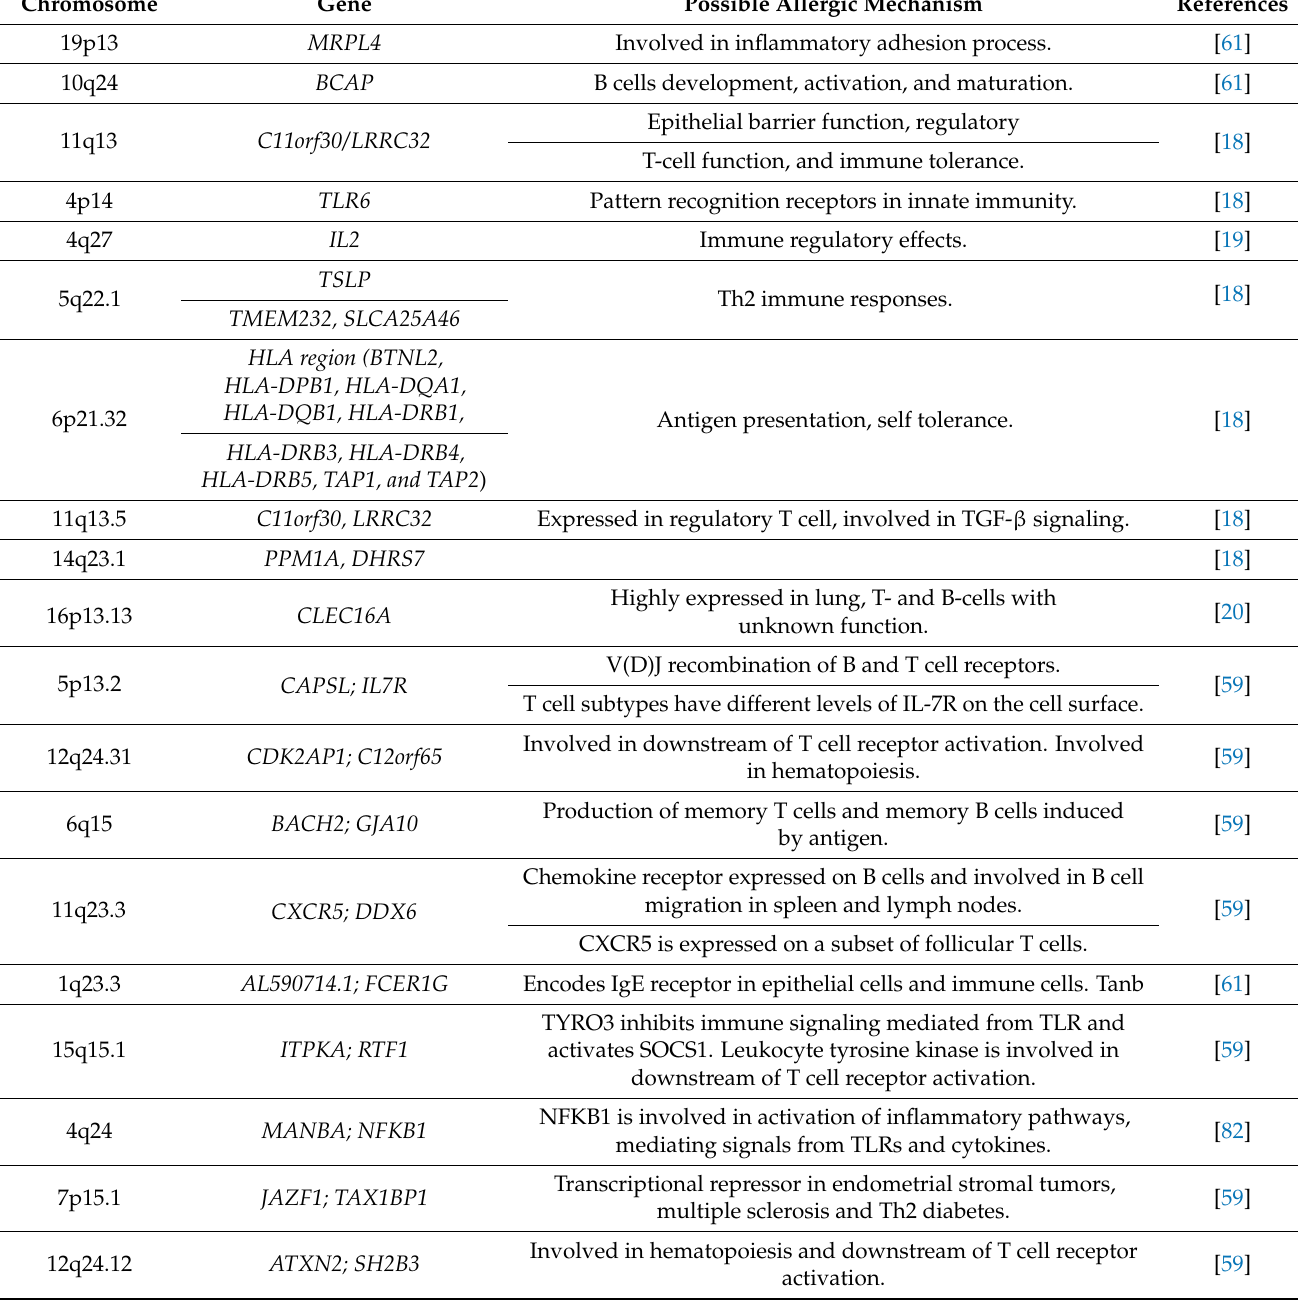
Table 1. Summary of genomic loci of allergic